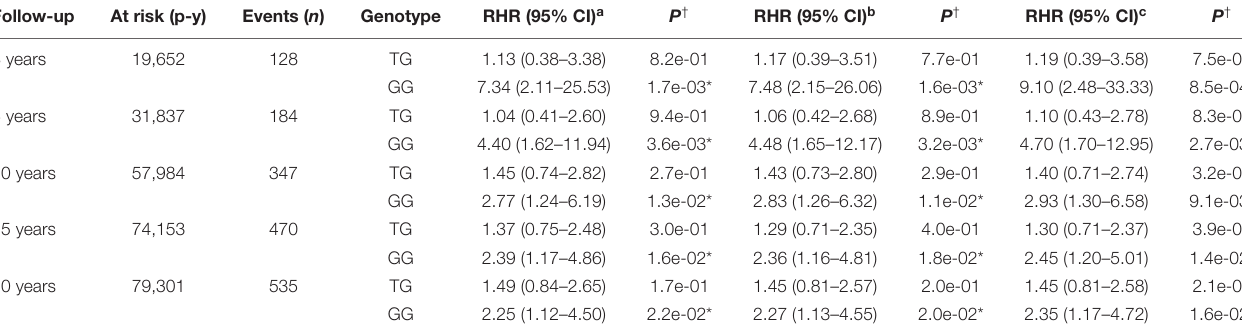
TABLE 2 | Pharmacogenetics interaction between exposure to L-thyroxine and INSR-rs4804416 on developing atrial fibrillation by follow-up time ( n =